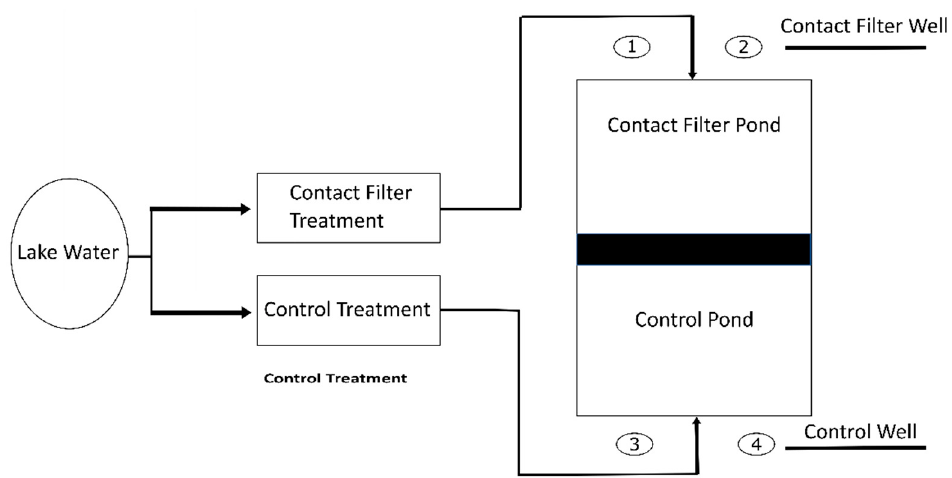
Figure 1. Study site overview. The lake is Lake Vomb from which water is led either through contact filter treatment or control treatment to their corresponding pond, i.e., contact filter pond and control pond.